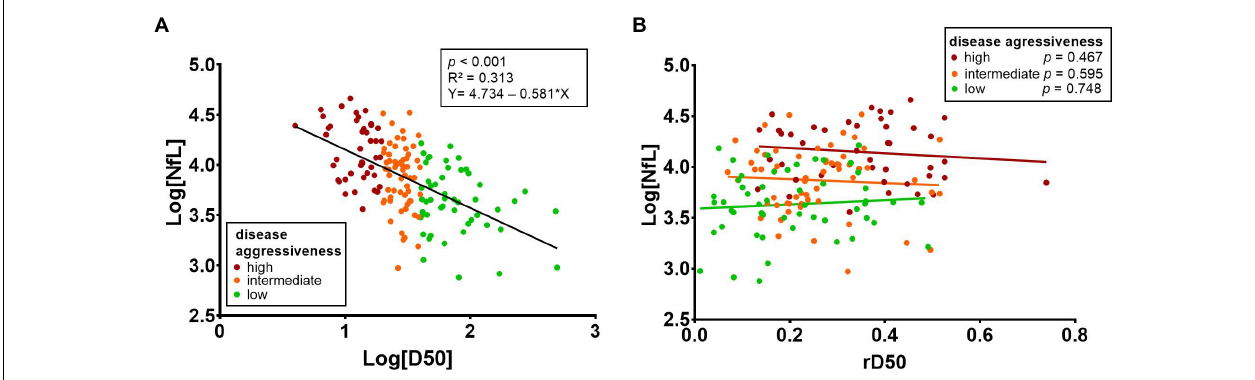
FIGURE 4 | (A) There was a negative correlation between the D50 parameter and CSF NfL ( p < 0.001, ρ = -0.553). Linear regression analysis showed that 31.3% of the variation in CSF NfL can be explained by the D50 parameter ( R 2 = 0.313, Log[NfL] = 4.734 - 0.581 × Log[D50]; p < 0.001). (B) Stratification of patients into the three aggressiveness subgroups (based on D50) reveals that there is no significant correlation of CSF NfL with rD50. CSF, cerebrospinal fluid; rD50, relative D50; NfL, neurofilament light